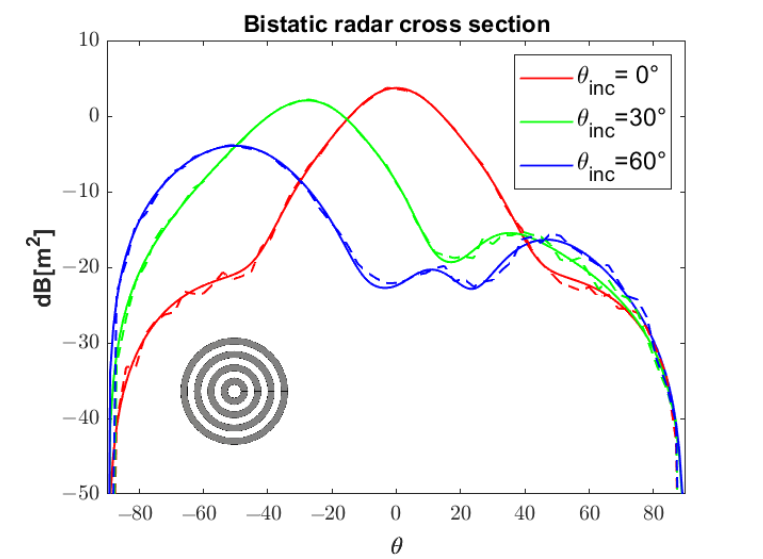
Figure 8. Bistatic radar cross section for geometry #2 (sketched in the inset) for different incidence angles θ inc . Solid line: this method; dashed line: CST Microwave Studio.